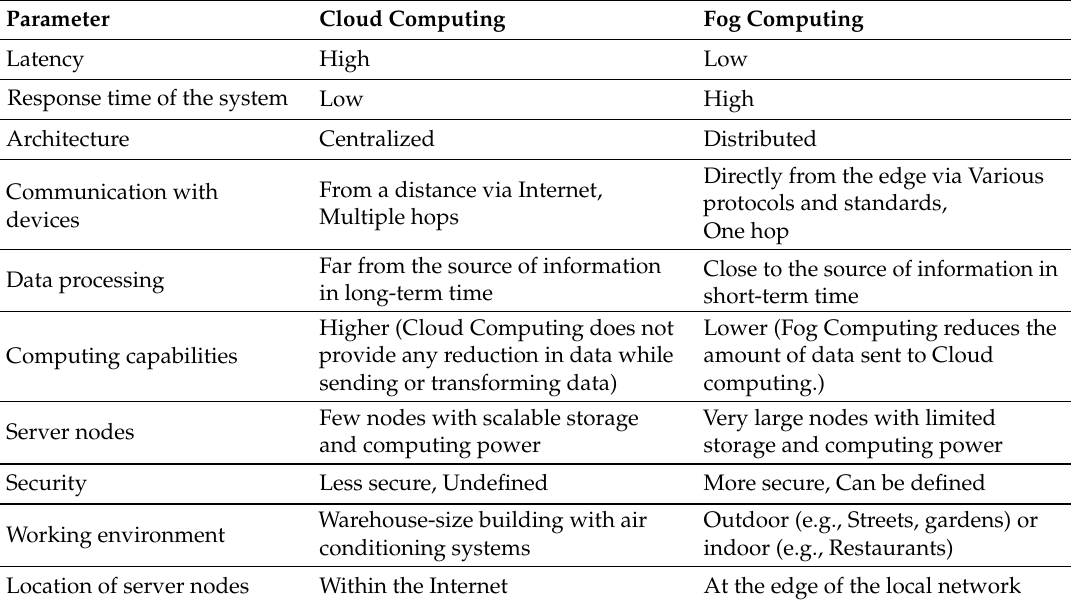
Table 1. Comparison between Cloud computing and Fog